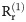
Differential expression analysis of alternative paths of differentiation using the 1-dimensional combinatorial Laplacian score.(a) The 0- and 1-dimensional combinatorial Laplacian scores were run over the scRNA-seq expression data of 3,582 cells from the differentiation of mESCs into MNs using the standard (SP) and direct programming (DP) protocols. The scatter plot represents the 0- and 1-dimensional combinatorial Laplacian scores of 10,063 genes. A k-nearest neighbor graph (k = 4) color-coded for expression (grey to red) is shown for some of the top differentially expressed genes identified by this method. Genes with low values of Rr(1) have upregulated expression along the cycle spanned by the two alternative paths of differentiation. For reference, the expression of a gene with high 0- and 1- combinatorial Laplacian scores (Pole3) is also displayed. (b) The 0- and 1-dimensional combinatorial Laplacian scores were run over the scRNA-seq expression data of 24,930 epithelial cells from the developing mouse (development stages E9.5-E13.5). Apical ectodermal ridge cells form a transient state that branches out and in from epithelial cells. The expression of genes with low value of Rr(1) localizes along the cycle spanned by the two alternative paths of differentiation. Examples of the expression of genes with low 0- and 1-dimensinoal combinatorial Laplacian score, low 0- and high 1-dimensional combinatorial Laplacian score, and high 0- and 1-combinatorial Laplacian score are shown (left).Gene set enrichment analysis (right) shows that genes with low 1-dimensional combinatorial Laplacian score are strongly enriched for genes that are upregulated in the alternative path for differentiation spanned by apical ectodermal ridge cells.